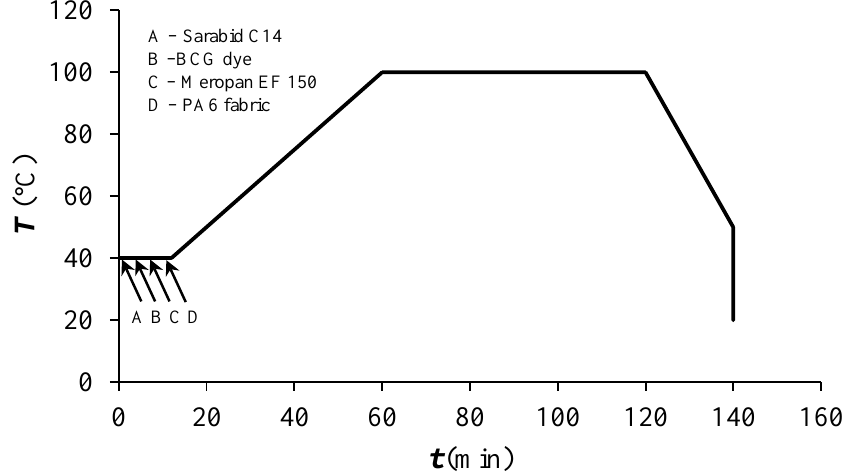
Figure 2. Shematic diagram of exhaust dyeing